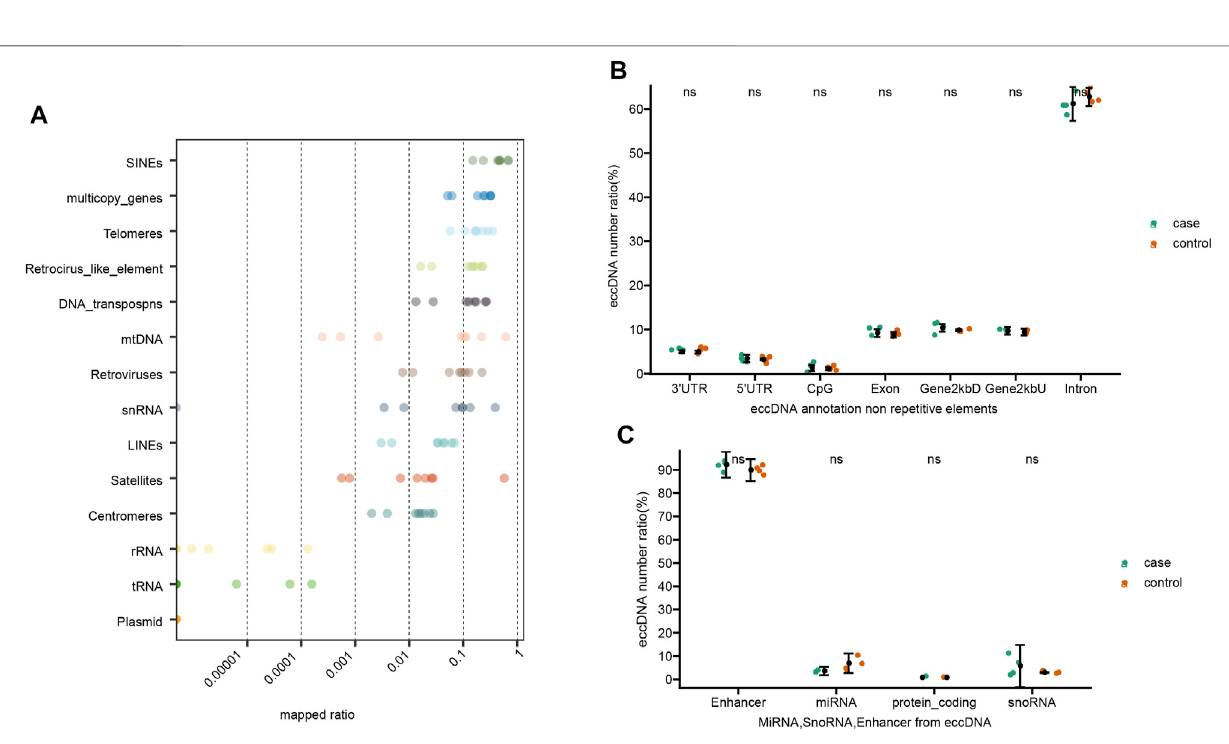
Frontiers in Genetics |